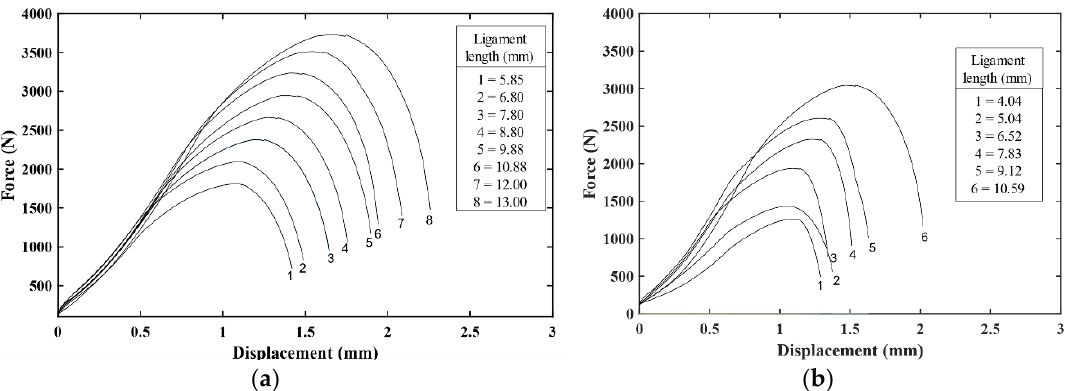
Figure 4. Force–displacement graph for all ligament lengths for: ( a ) Notched specimens; ( b ) Fatigue pre-cracked specimens.